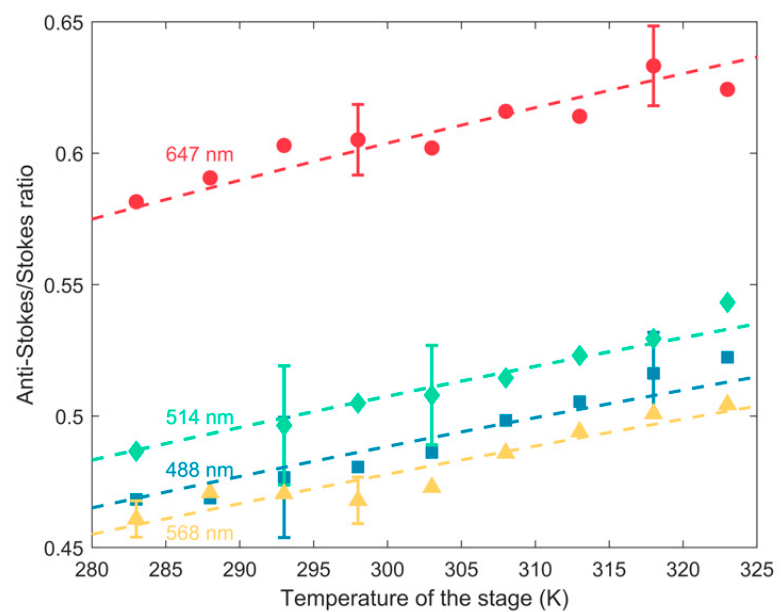
Figure 7. Experimental anti-Stokes/Stokes ratios of the 143 cm − 1 E g mode of anatase as a function of the temperature, and corresponding calibration curves; data are collected by exciting at different wavelengths: 488.0 (blue squares and dashed line), 514.5 (green diamonds and dashed line), 568.2 (yellow triangles and dashed line) and 647.1 nm (red circles and dashed line). Table 5. Calibration constants for the 143 cm − 1 Raman mode at four different wavelengths. Excitation Wavelength [nm] Calibration Constant R 2